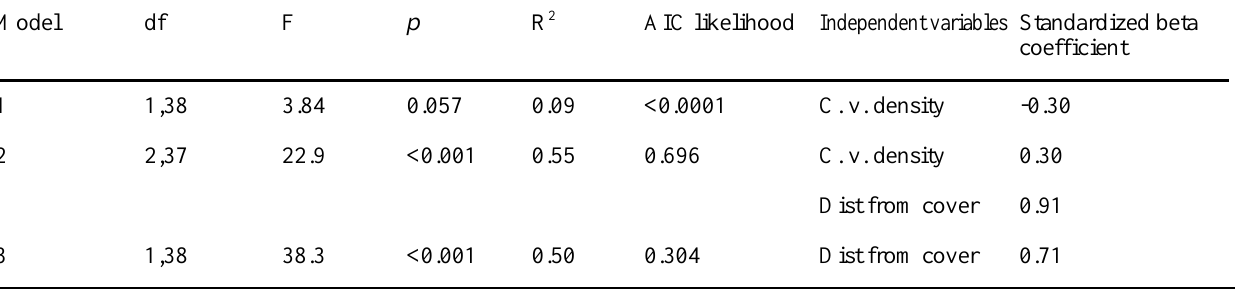
Table 4. Results of multiple regression and AIC model selection for factors predicting habitat use by sandpipers foraging at low tide. Note that other factors, including predators and attacks per hour and mudflat area had to be excluded from these models because of multicollinearity. C. v. density refers to August density of C. volutator . Dist from cover refers to maximum distance from cover that a bird can forage on a mudflat. AIC model likelihood was calculated from AICc